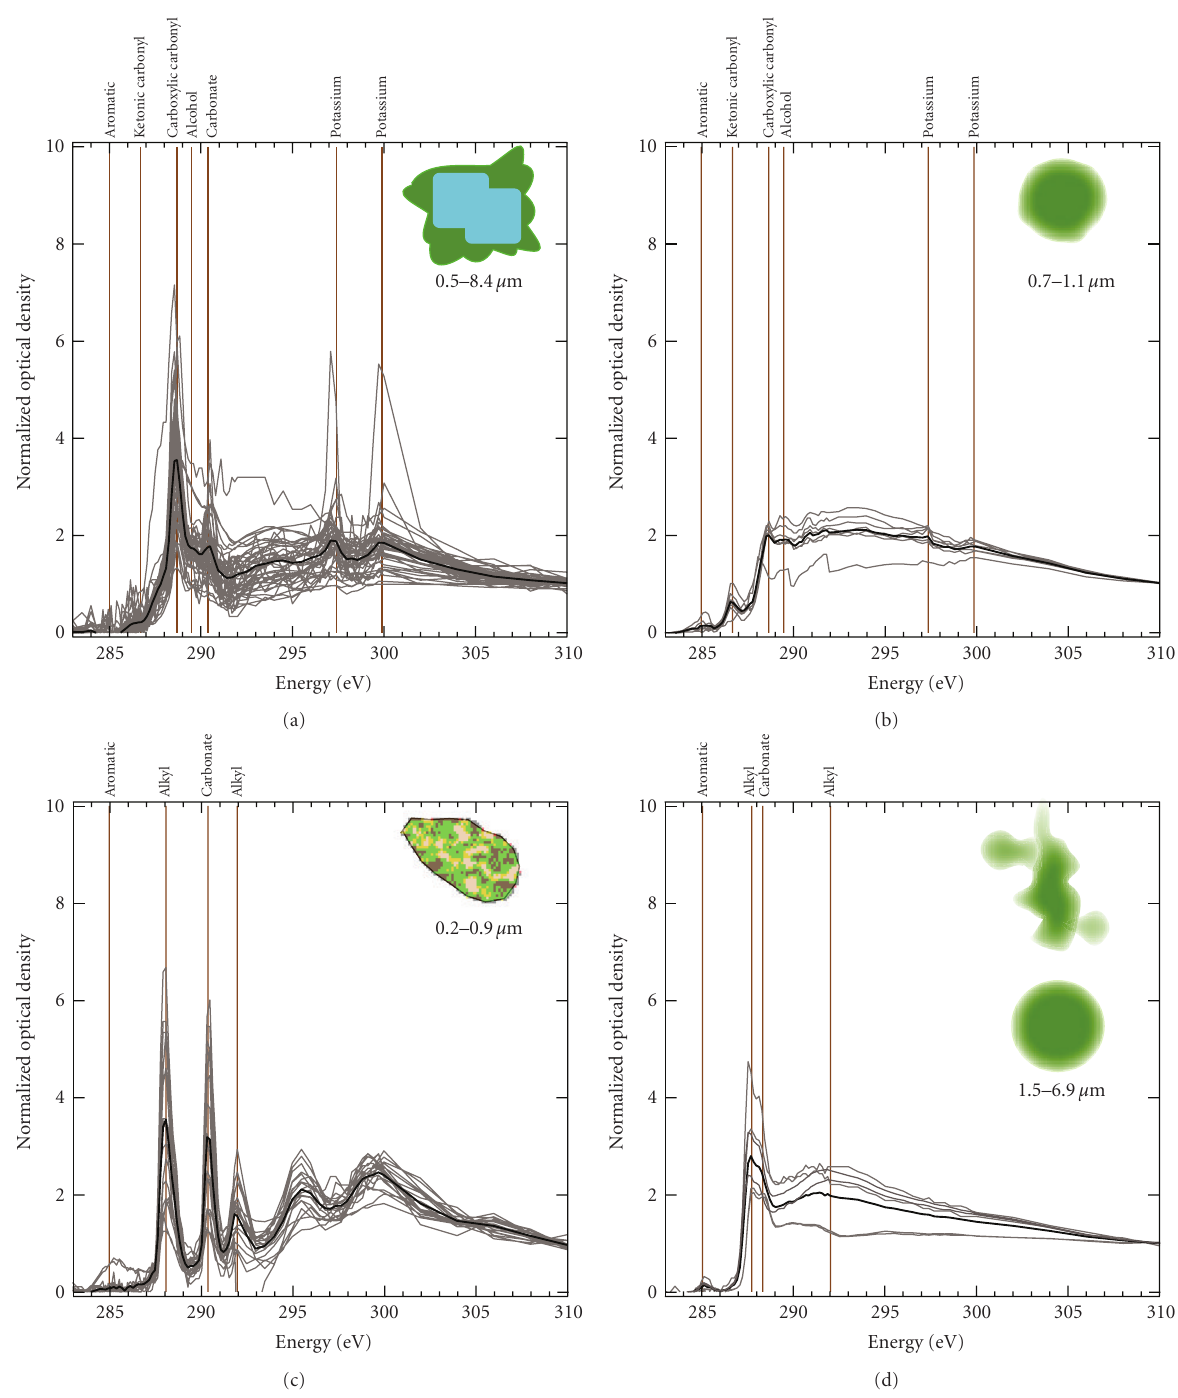
Figure 2: Individual (grey) and average (black) NEXAFS spectra of the four marine particle types including (a) PsI, (b) PsII, (c) calcareous phytoplankton fragments, and (d) proteinaceous particles. Illustrations in each panel represent commonly observed morphologies associated with each spectra type. The observed size range for each type is shown below the